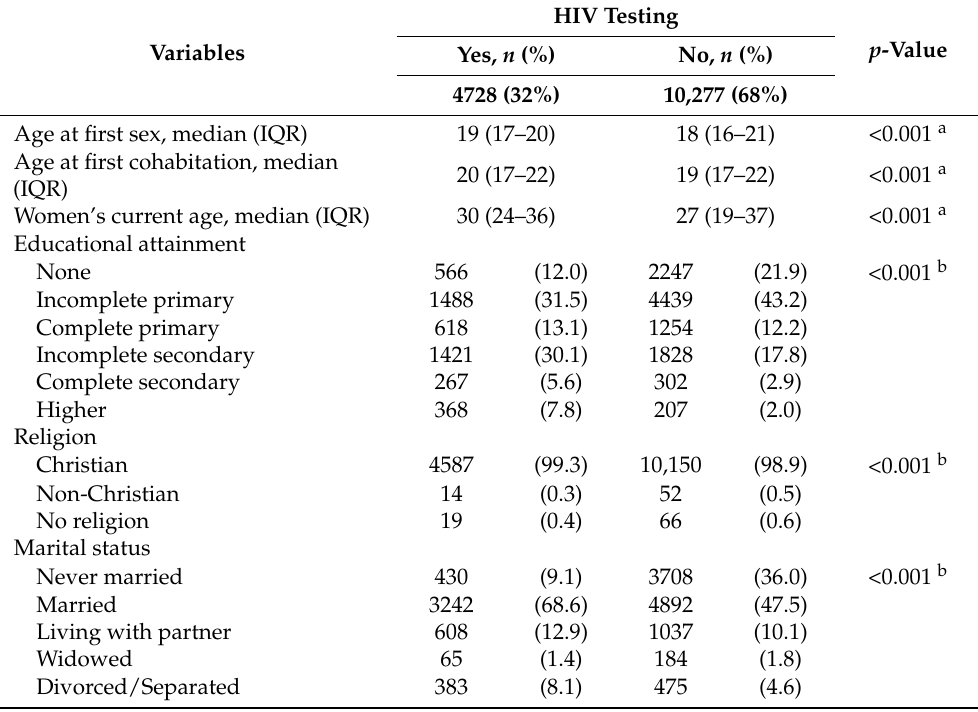
Table 2. Distribution of HIV testing among the study